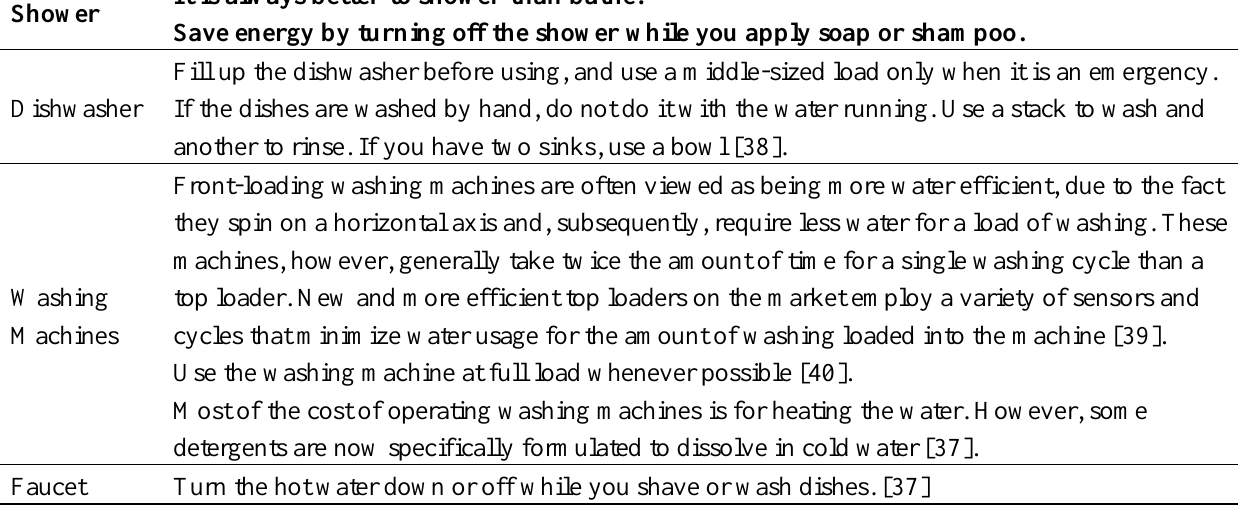
Table 12. Recommendations to save energy and water.